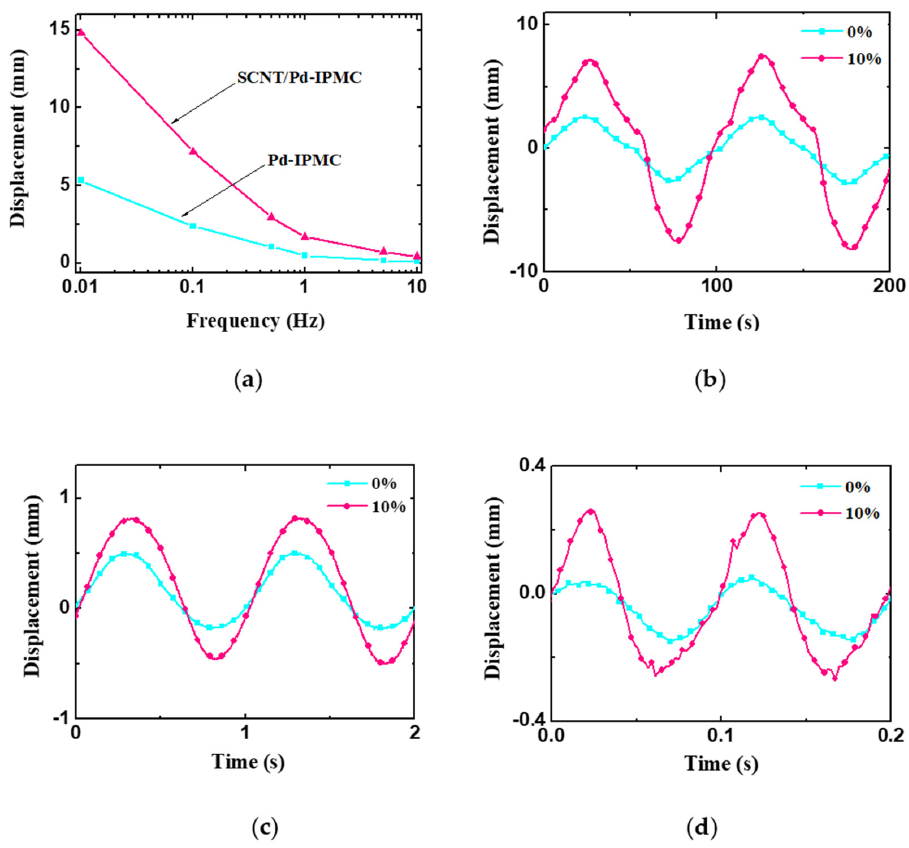
Figure 8. Actuation bending deformations of the IPMCs. ( a ) Harmonic response under ±2 V sinusoidal voltage; ( b ) displacement curves at 0.01 Hz; ( c ) displacement curves at 1 Hz; ( d ) displacement curves at 10 Hz.